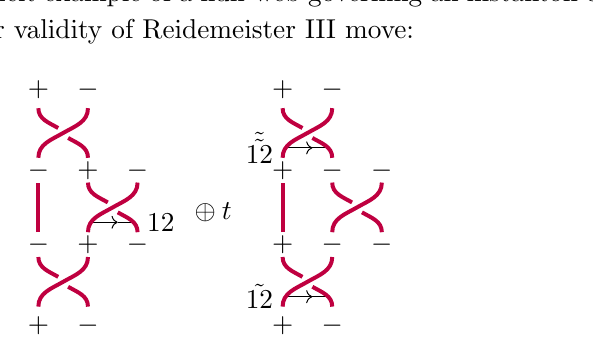
Figure 10 . Emerging null-web example for Reidemeister III for speci(cid:12)cation z 1 = z 3 = 1 + i x , c =